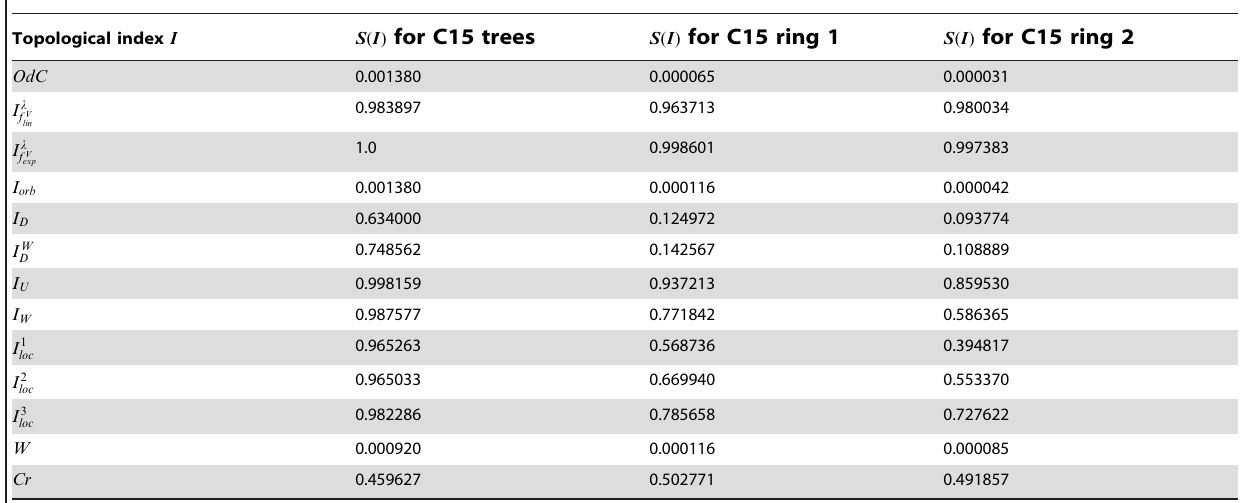
Table 2. Calculation of sensitivity index S ( I ) for synthetic graph classes.